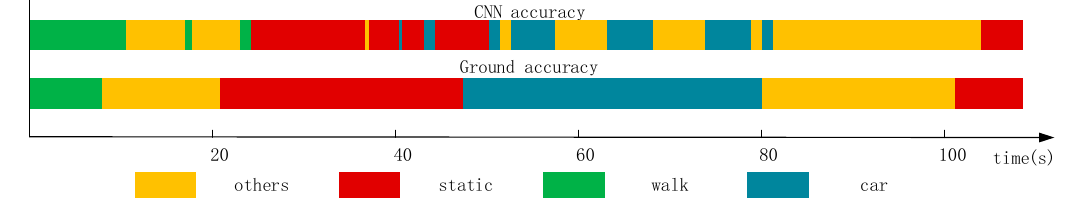
Figure 1. Recognition results obtained using the CNN method. The upper band called CNN accuracy is the result based on CNN method. The lower band named ground accuracy is the real movement results as a reference of CNN accuracy.